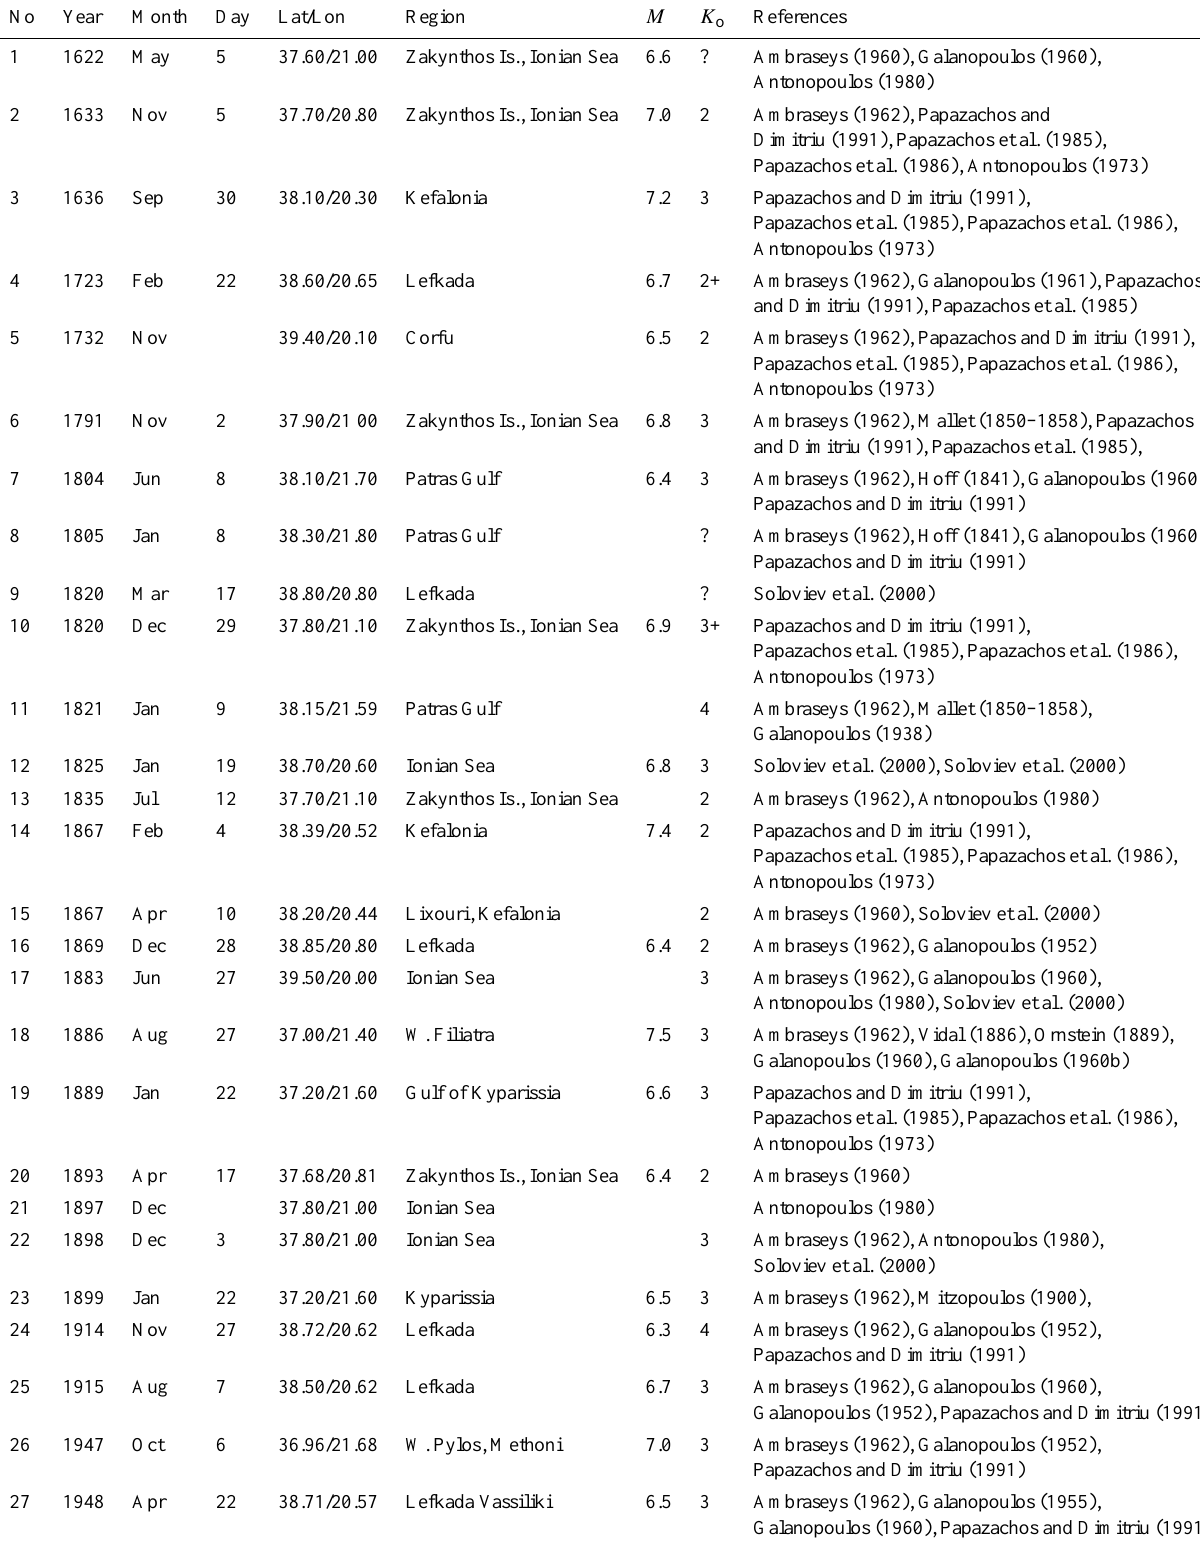
Table 1. Possible, locally generated, tsunami along the western Hellenic arc fault system. K o is the intensity of the wave and it refers to Sieberg’s modified intensity scale